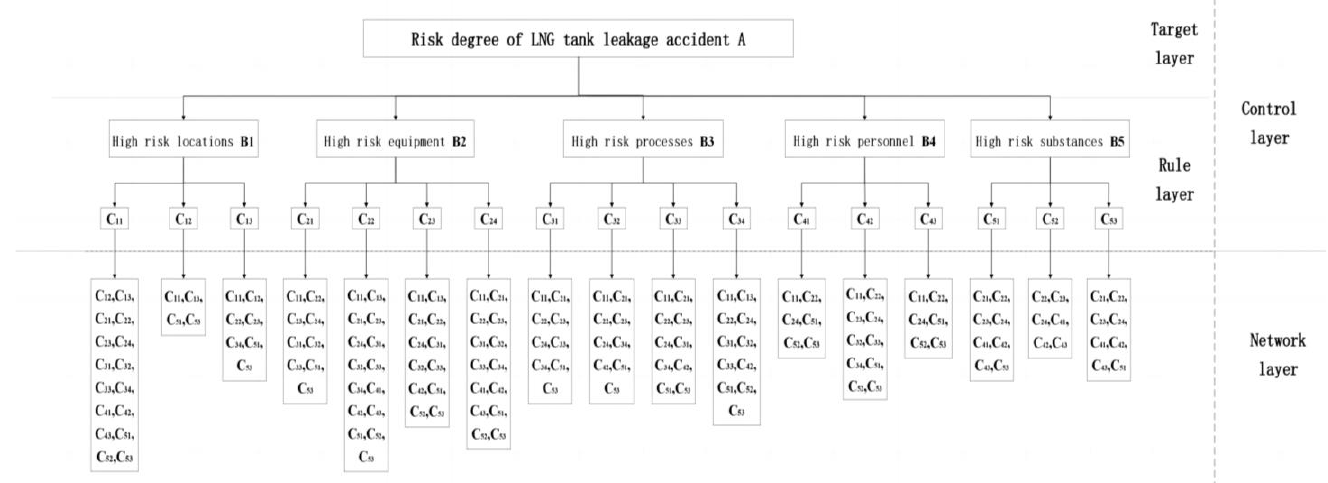
Figure 3. The diagram of LNG storage tank leak assessment indicator system.